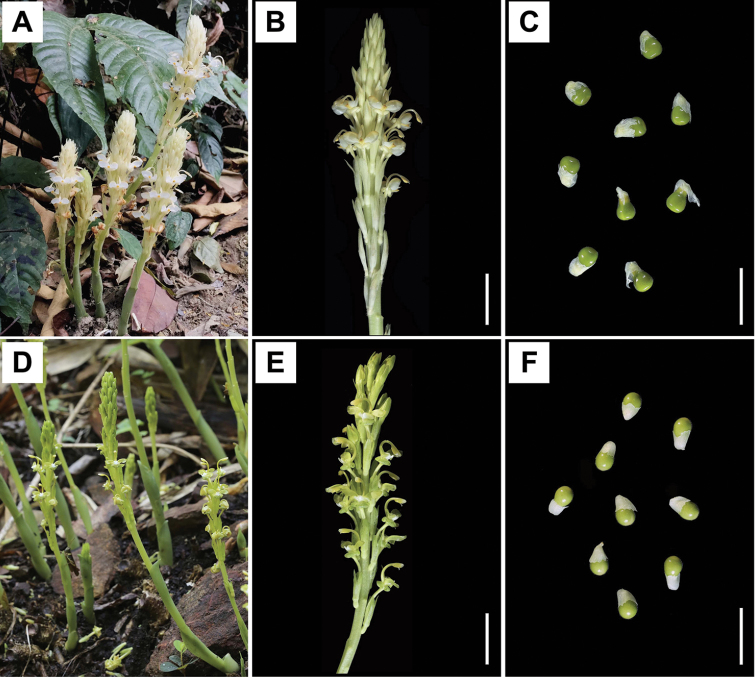
Gagnepainia spp. in Thailand. A–CG.
godefroyiA inflorescences in habitat (PMNN022) B detail of inflorescences (PMNN011) C seeds (PMNN011) D–FG.
harmandiiD inflorescences in habitat (PMNN006) E detail of inflorescences (PMNN006) F seeds (PMNN006). Scale bars: 2 cm (B, E); 1 cm (C, F). Photo by N. Nopporncharoenkul.